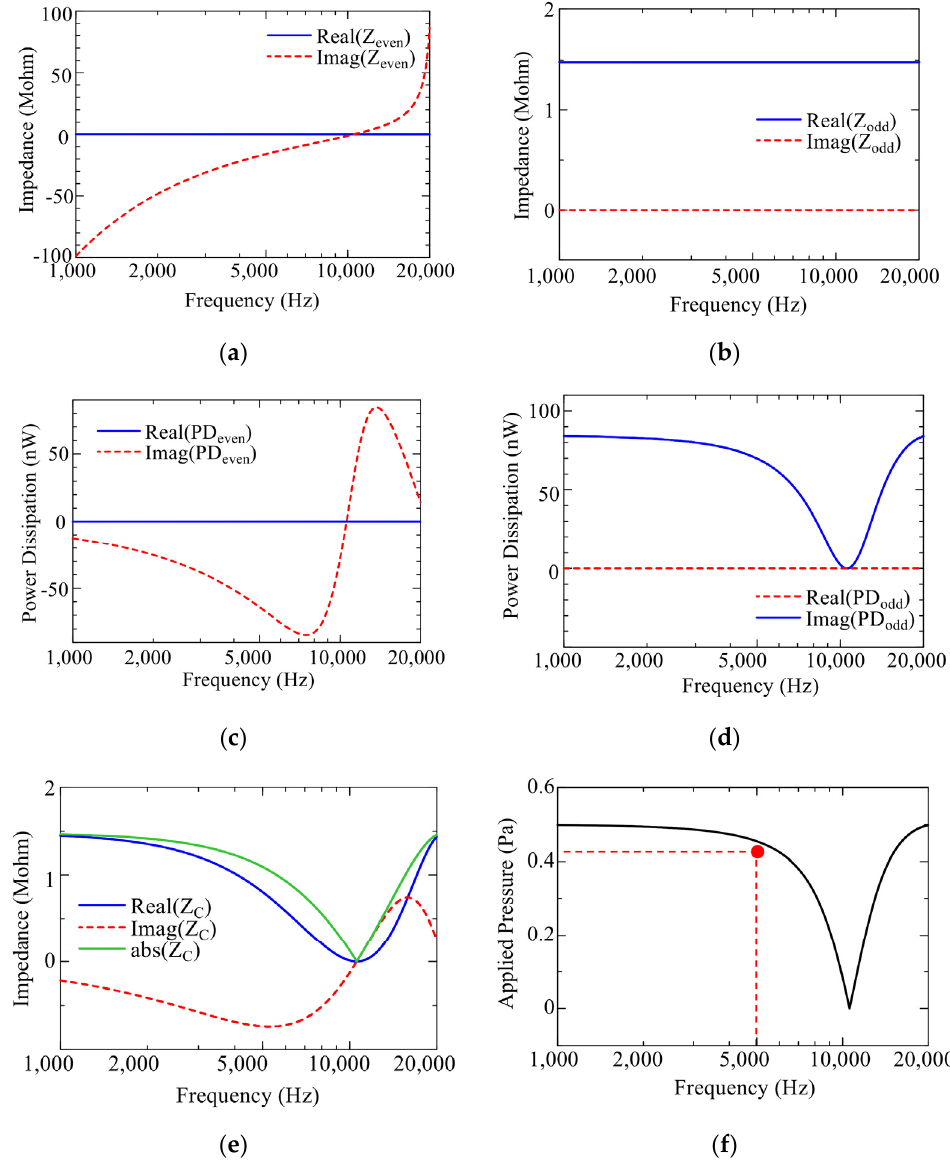
Figure 9. Equivalent circuit simulation results when a 1 Pa input ( v g = 1.0 V) is applied to the voltage source in Figure 8b. ( a ) Input impedance of the even mode. ( b ) Input impedance of the odd mode. ( c ) Power dissipation of the even mode. ( d ) Power dissipation of the even mode. ( e ) Input impedance of the cochlea. ( f ) The actual pressure applied to the cochlea under the impedance mismatch between the source and cochlea. The red point shows an applied pressure at 5000 Hz, which is calculated by the FEM–based structural simulation of the even and odd mode sound waves in Figure